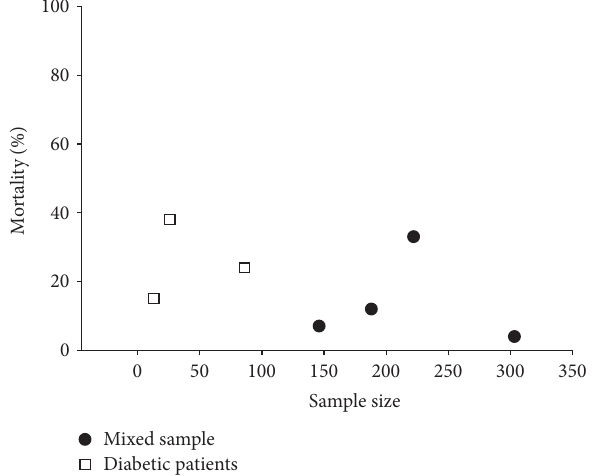
Diabetic patients F 3: Reported mortality in published case series of patients with gastroparesis (black circles: mixed etiology; white squares: diabetic